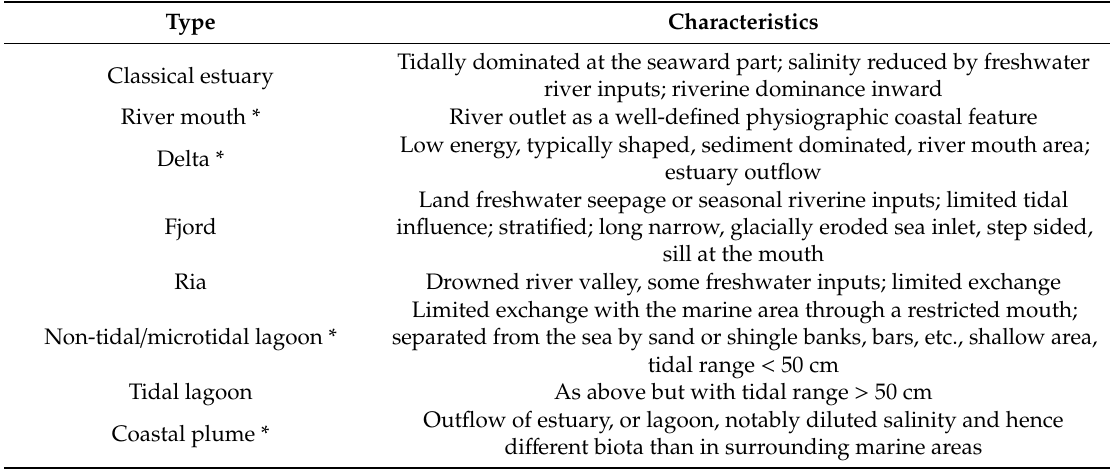
Table 1. Main physiographic forms included under the term transitional waters Type